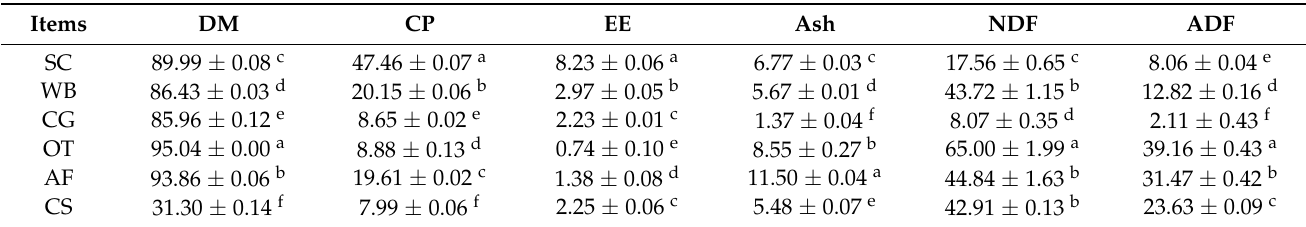
Table 2. Chemical composition of six kinds of organic feed (% DM basis).